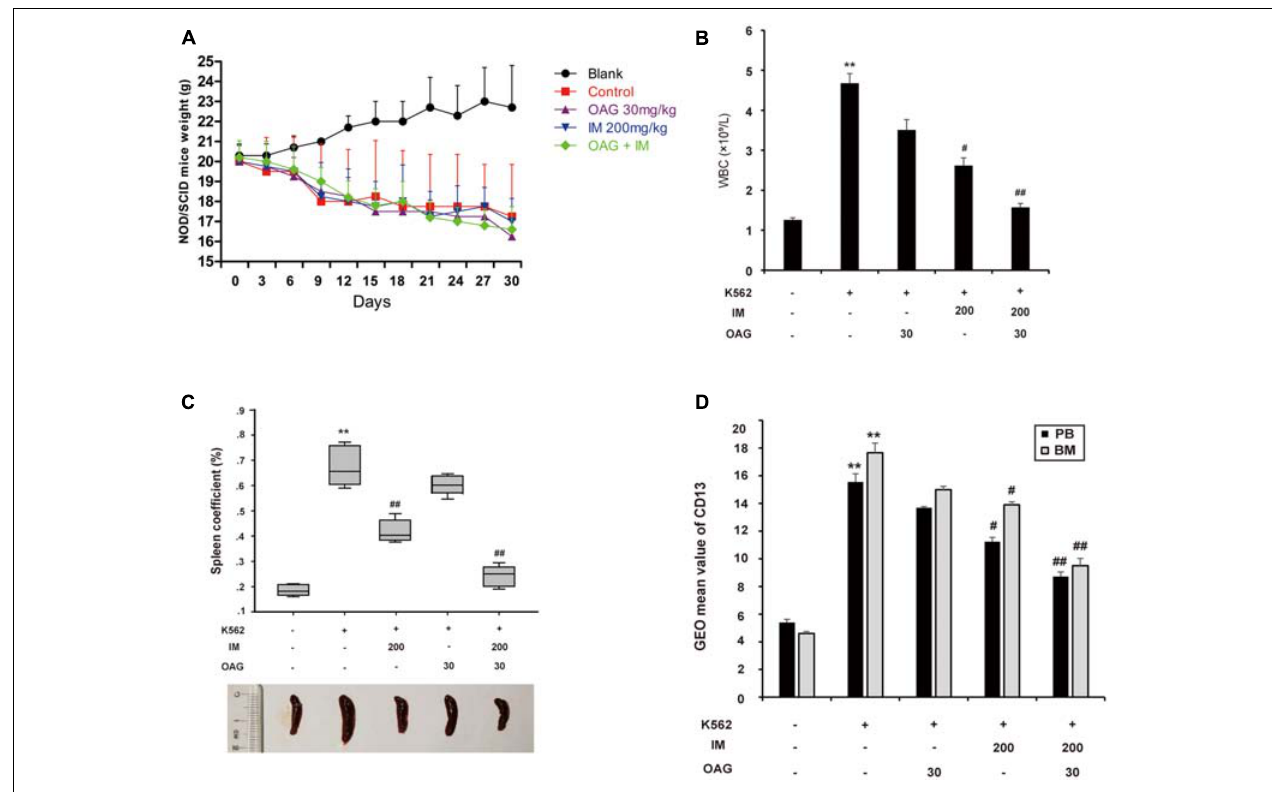
FIGURE 5 | Oroxyloside A potentiated CML repression by IM in vivo . (A) NOD/SCID mice weight was recorded in all groups every 3 days. (B–D) At the end of experiment, all animals were sacrificed and samples were collected to analyze WBC (B) , the weight of spleen (C) and expression of CD31 in PB and BM (D) . The data represent mean values of three experiments ± SD. ( ∗∗ p < 0.01 compared with blank group and ## p < 0.01, # p < 0.05 compared with control